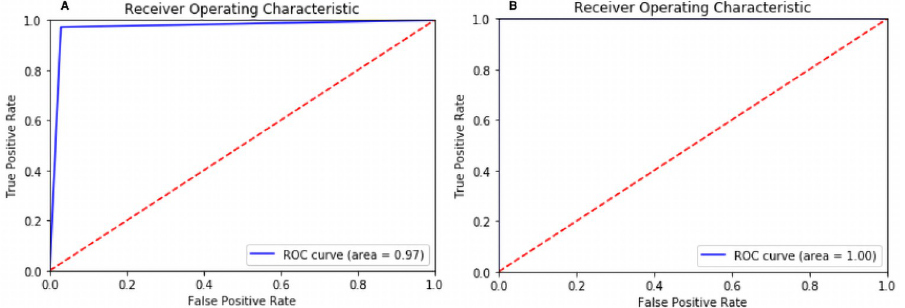
Fig 13. ROC curve in scenario I for (A) build CNN and (B)